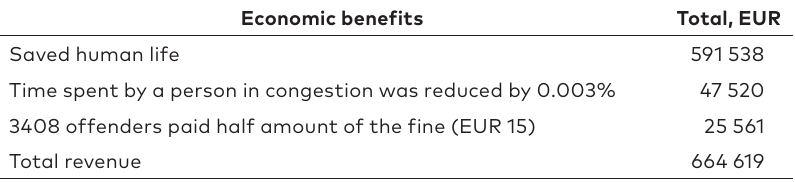
Table 3. Economic benefits of Automatic Incident